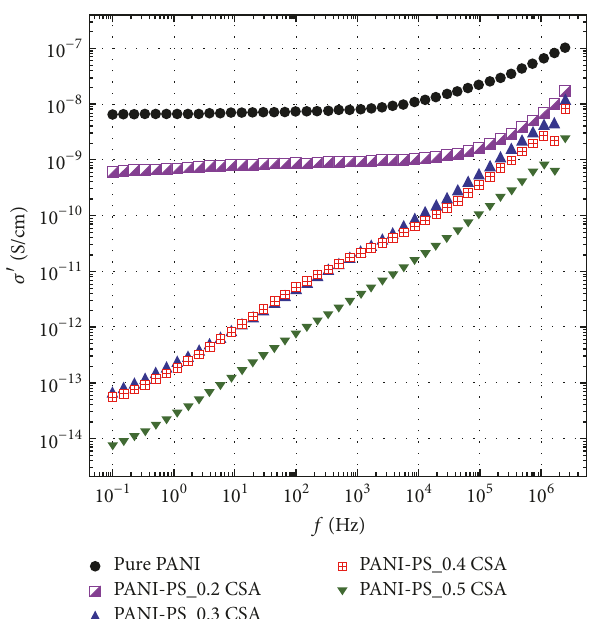
Figure 4: AC conductivity versus frequency at 20 ∘ C for pure PANI and PANI-PS blends samples with different composition.